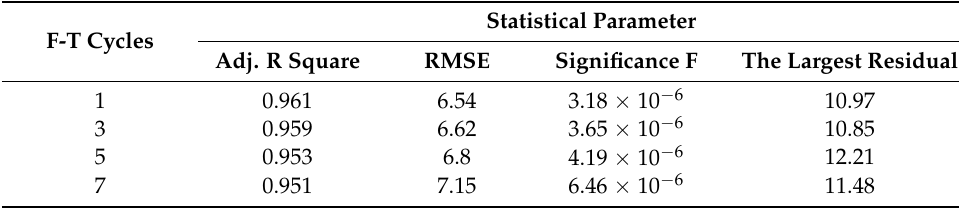
Figure 5. Error distribution diagram. Table 6. Regression parameters of predicted and measured values. Table 6. Regression parameters of predicted and measured